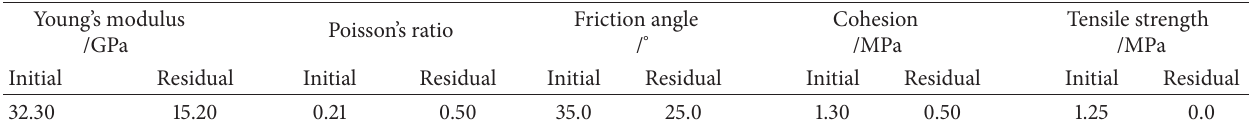
Table 2: Equivalent mechanical parameters of the